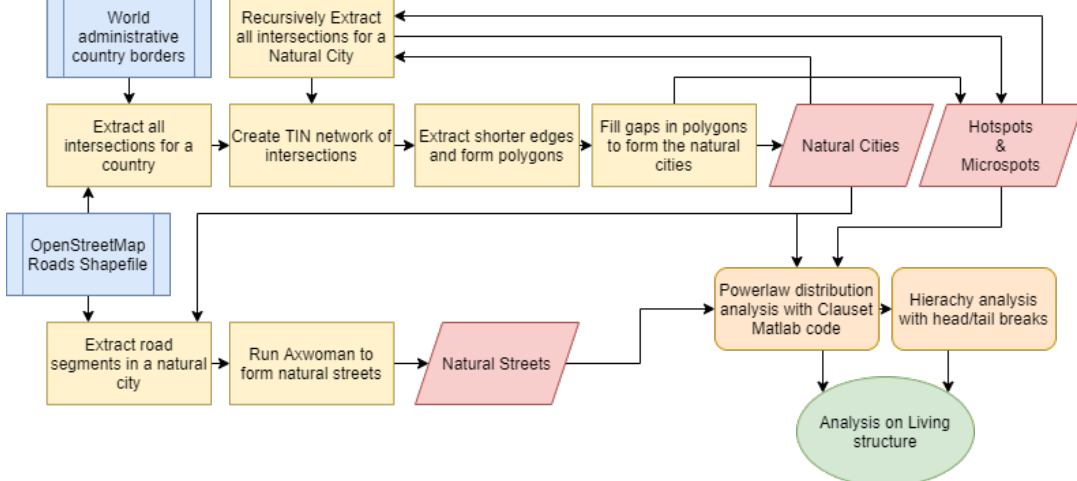
Figure 2. Generating natural cities from road intersections. Panel ( a ) shows the constructed TIN lines connecting each intersection to each other based on proximity. Panel ( b ) shows the same dataset, however the longer distances determined by head/tail breaks have been removed. The final panel ( c ) shows the natural cities derived from the input OSM roads [23].